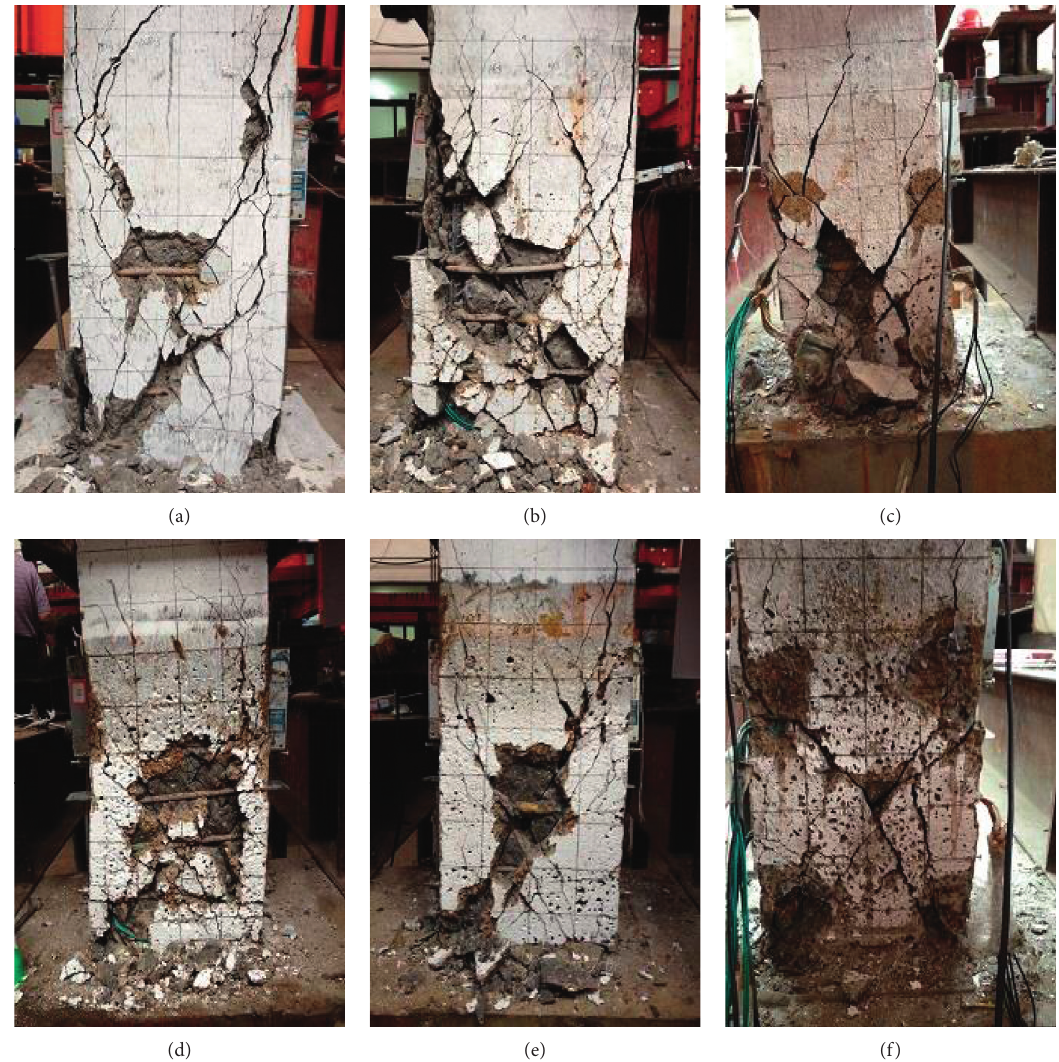
Figure 6: Ultimate crack patterns and failure morphologies of the specimens: (a) SC-1; (b) SC-2; (c) SC-3; (d) SC-4; (e) SC-5; (f)